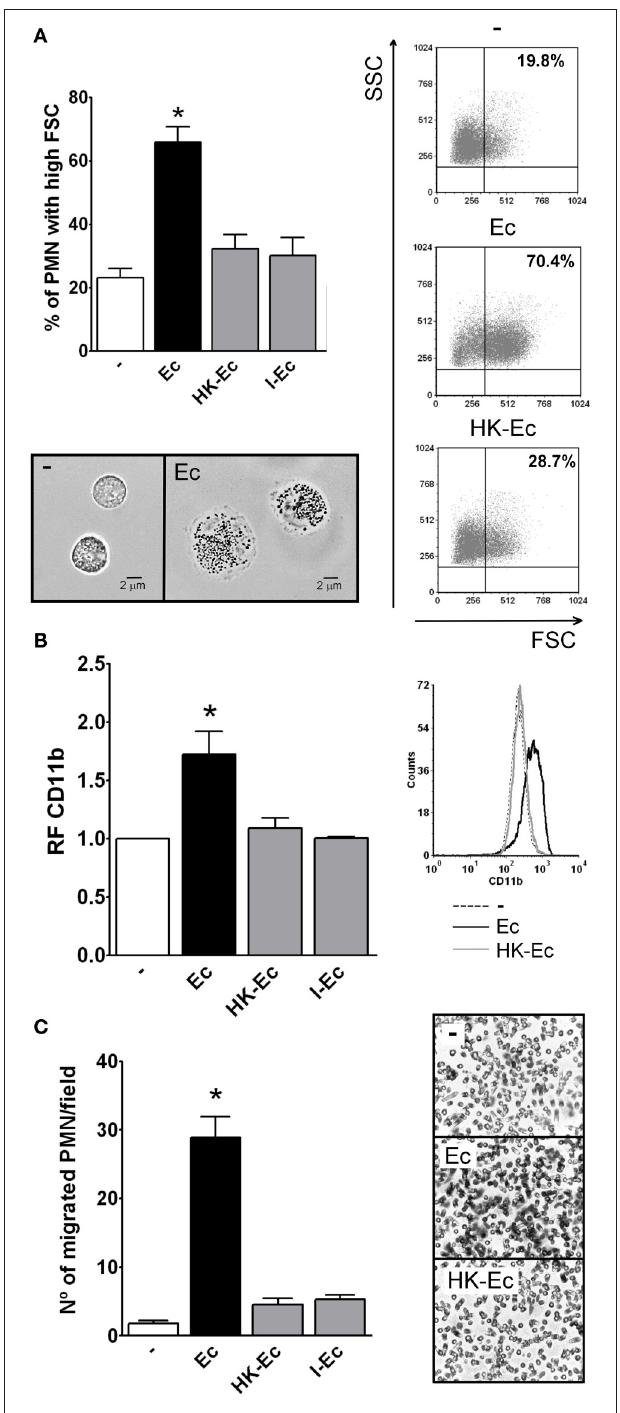
FIGURE 1 | Live bacteria triggers the first steps of PMN activation. Isolated PMN were treated with live bacteria or bacteria killed by different methods in a PMN:bacteria ratio of 1:20 for 30 min. (A) The % of PMN that increased their FSC after stimulation with live E. coli (Ec), heat-killed Ec (HK-Ec), irradiated Ec (I-Ec), or left untreated ( − ) was determined by flow cytometry. Results were expressed as the mean ± ES, n = 14. Right panel : representative dot-plots showing SSC vs. FSC profiles of PMN with no treatment ( − ), Ec, and HK-Ec. Lower panel